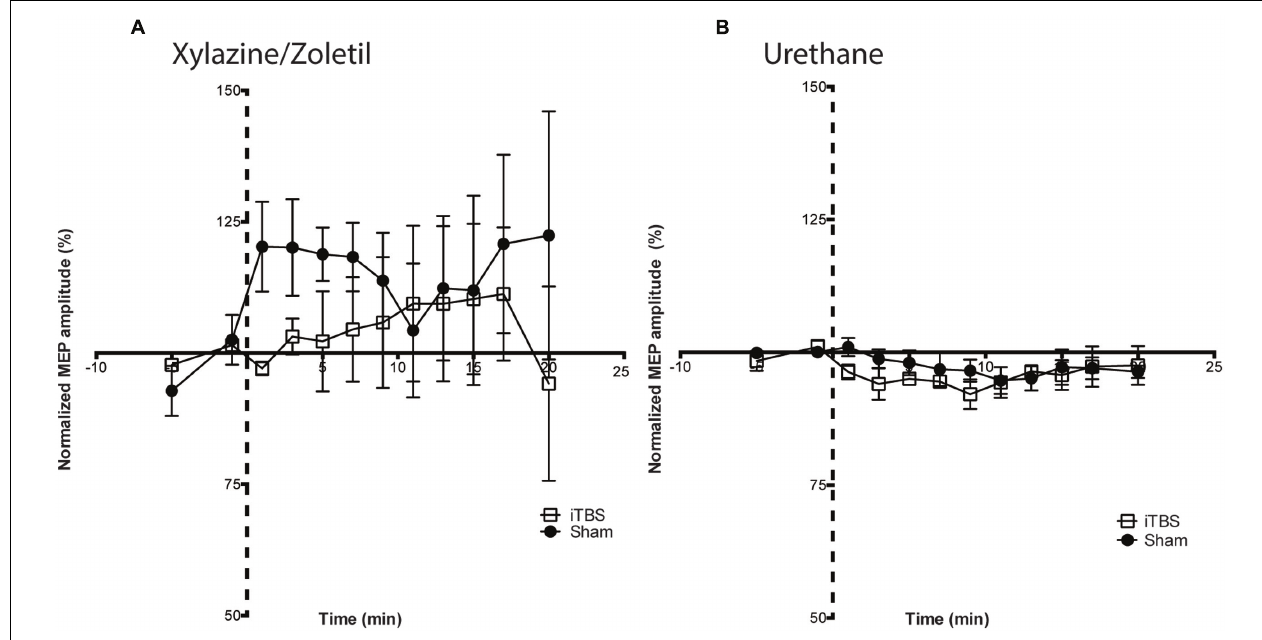
FIGURE 5 | Intermittent theta-burst stimulation did not significantly affect MEP amplitudes recorded in animals anesthetized with either (A) xylazine/zoletil (iTBS = 5; Sham = 4) or (B) urethane (iTBS = 5; Sham = 4). Note the baseline data are truncated to 5 min preceding the protocols. All data shown are mean ± SEM. Normalized amplitudes from each minute are grouped into 2-min bins. Dashed axis line indicates Sham or iTBS treatment (time point